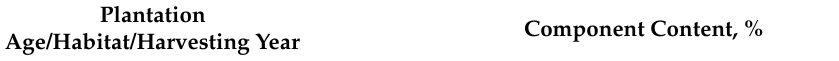
Table 2. Chemical composition of Miscanthus × giganteus differing in plantation age and habitat